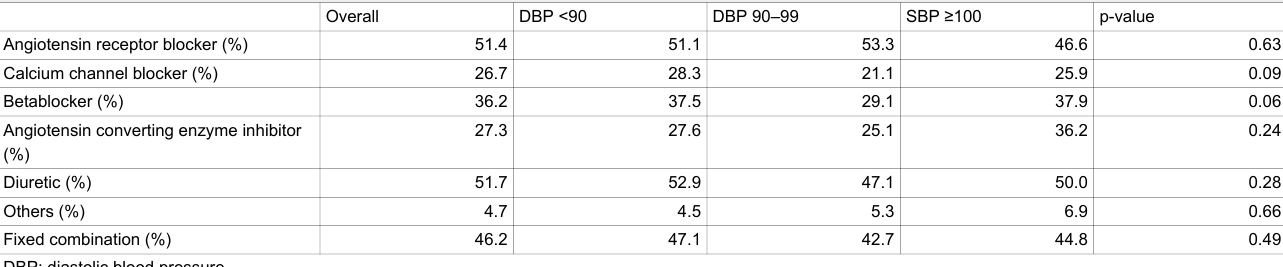
Angiotensin converting enzyme inhibitor (%) Others (%)